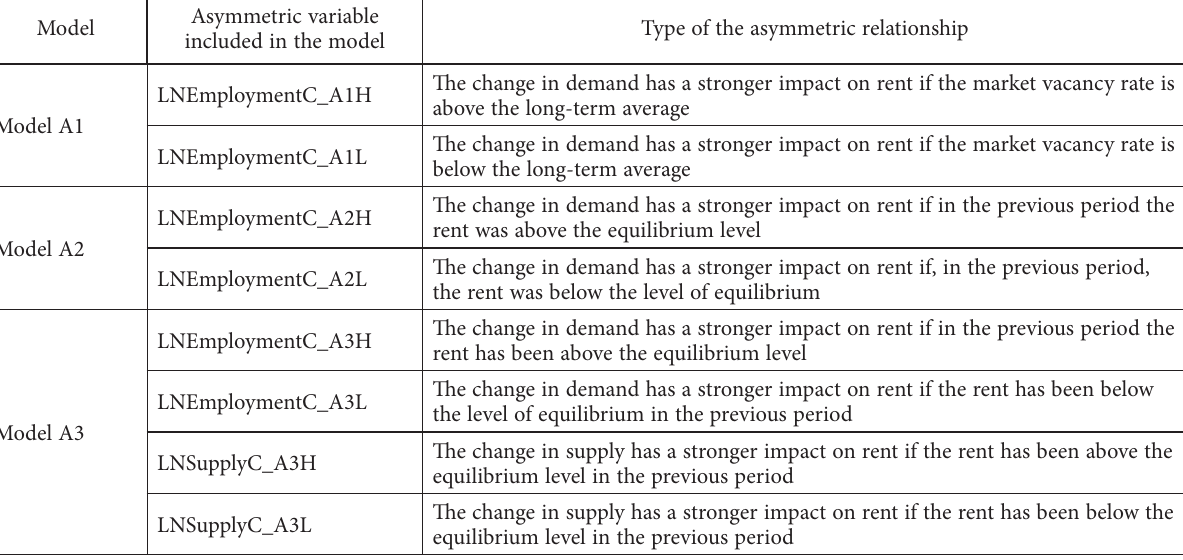
Type of the asymmetric relationship